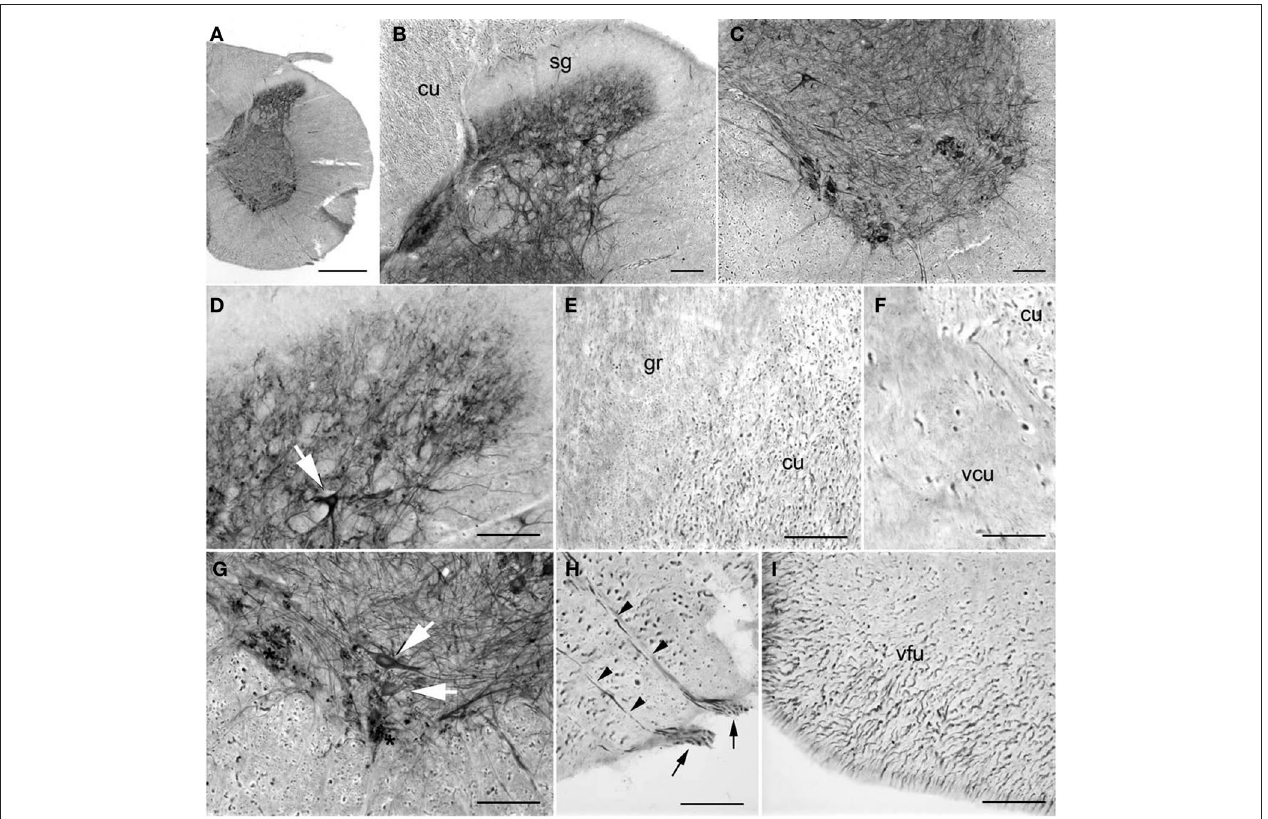
Figure 12 | PlexinA4 in spinal cord. Micrographs of coronal sections from an adult rat spinal cord stained for PlexinA4. PlexinA4 staining is visible in neurons (arrows) and fibers in the dorsal (B and D) and ventral (C and g) horns. PlexinA4 positive axon bundles are mostly found in the dorsal part of the cuneate fasciculus (cu) region (e and F) and the ventral funiculus (i) .